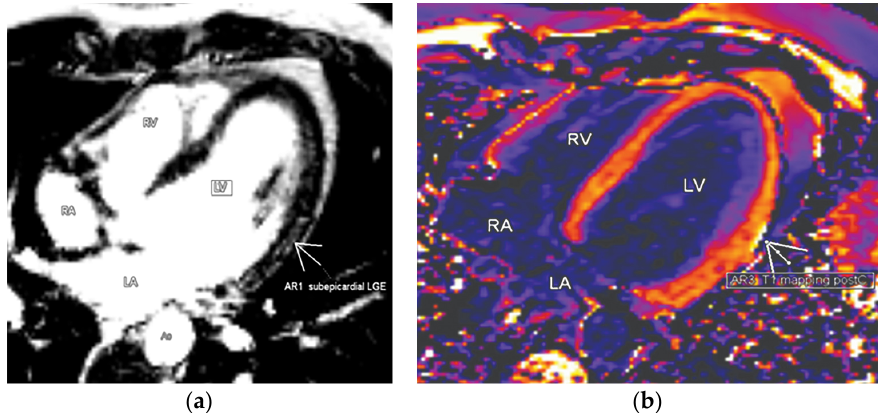
Figure 4. Cardiac magnetic resonance. ( a ) Four-chamber view ten minutes from the application of gadolinium with detection of the late gadolinium enhancement in the mid-lateral left ventricular wall. ( b ) Myocardial mapping (four-chamber view) showed elevated T1 signals of the mid-lateral left ventricular wall, with the enhancement of the adjacent pericardium also confirming the presence of pericarditis.